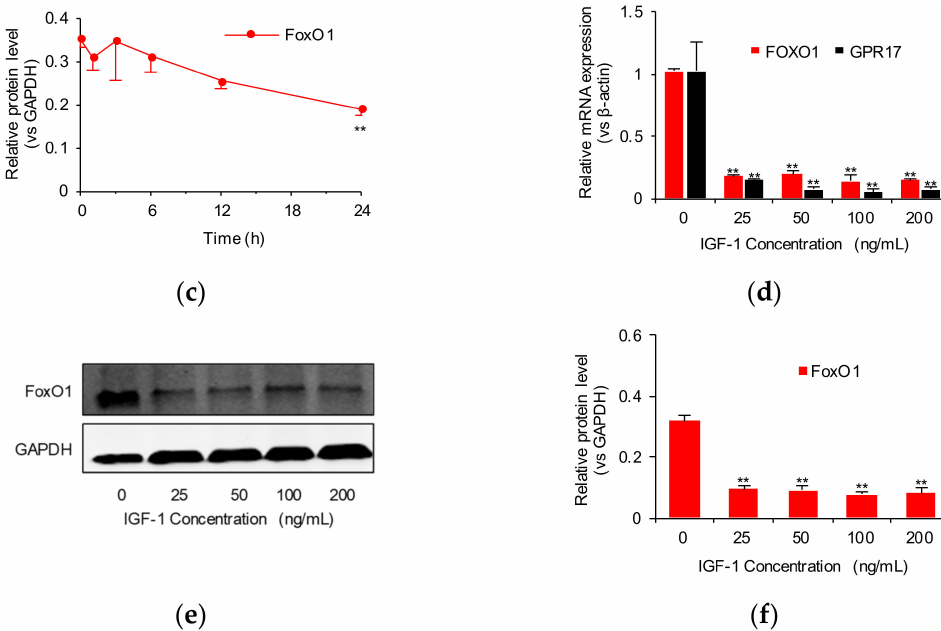
Figure 1. IGF-1 regulates the expression of FoxO1 and GPR17 in SK-N-SH cells. ( a ) FOXO1 and GPR17 mRNA expression induced by 100 ng/mL of IGF-1 within 24 h (1, 3, 6, 12, and 24 h); ( b ) Western blot analysis of FoxO1 expression induced by 100 ng/mL of IGF-1 within 24 h; ( c ) quantification of FoxO1 protein levels induced by 100 ng/mL of IGF-1 within 24 h; ( d ) influence of IGF-1 at different concentrations (0, 25, 50, 100, and 200 ng/mL) on FOXO1 and GPR17 mRNA expression at 24 h; ( e ) Western blot analysis of FoxO1 protein expression induced by different concentrations of IGF-1 (0, 25, 50, 100, and 200 ng/mL) at 24 h; ( f ) quantification of FoxO1 protein expression induced by different concentrations of IGF-1 (0, 25, 50, 100, and 200 ng/mL) at 24 h. Results were obtained from three separate experiments. ** p < 0.01 vs. 0 h or 0 ng/mL in the IGF-1 group.